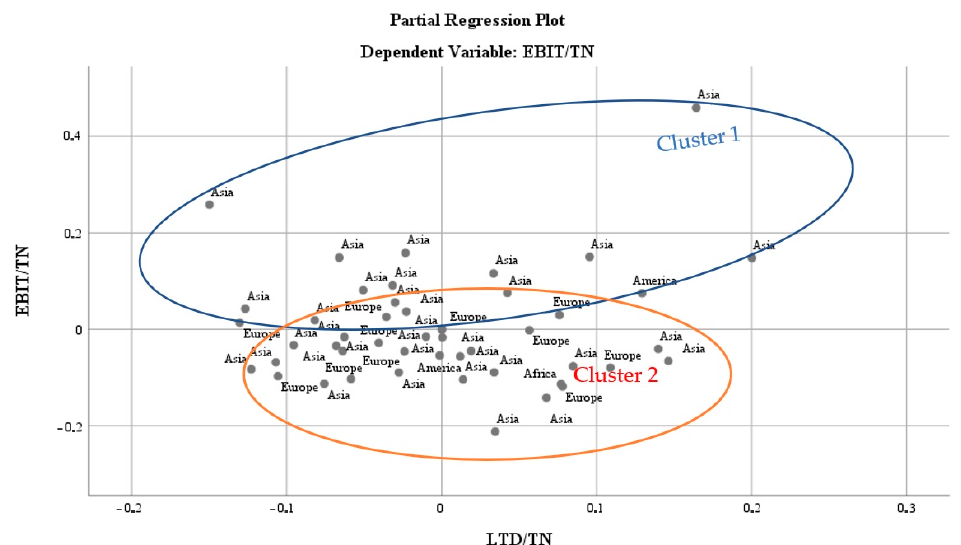
Figure 6. Distribution clusters of the value of the regressor return on the use of borrowed capital on the overall economic performance rate.